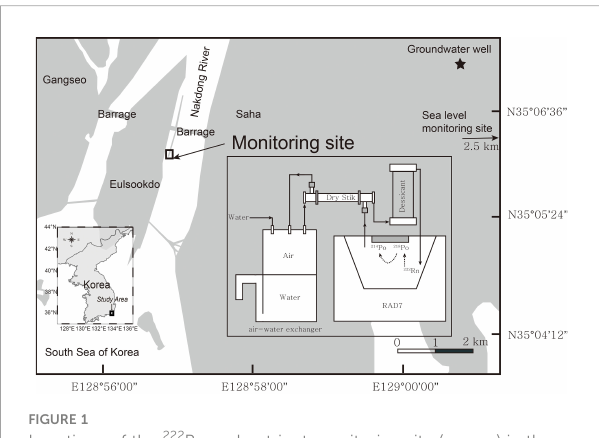
FIGURE 1 Locations of the 222 Rn and nutrient monitoring site (square) in the Nakdong River estuary and the groundwater level monitoring station (star). A schematic diagram of the measurement system, which uses a radon monitor (RAD7) and air-water exchanger, is also